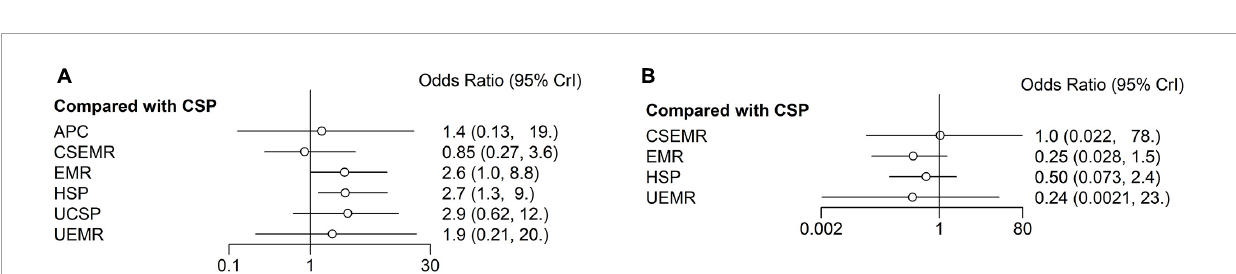
FIGURE4 Forest plots reporting the results of the network meta-analysis. (A) Complete resection rate. (B) Intraprocedural bleeding rate. Reference was CSP. CSP, cold snare polypectomy; HSP, hot snare polypectomy; EMR, endoscopic mucosal resection; APC, argon plasma coagulation; UCSP,